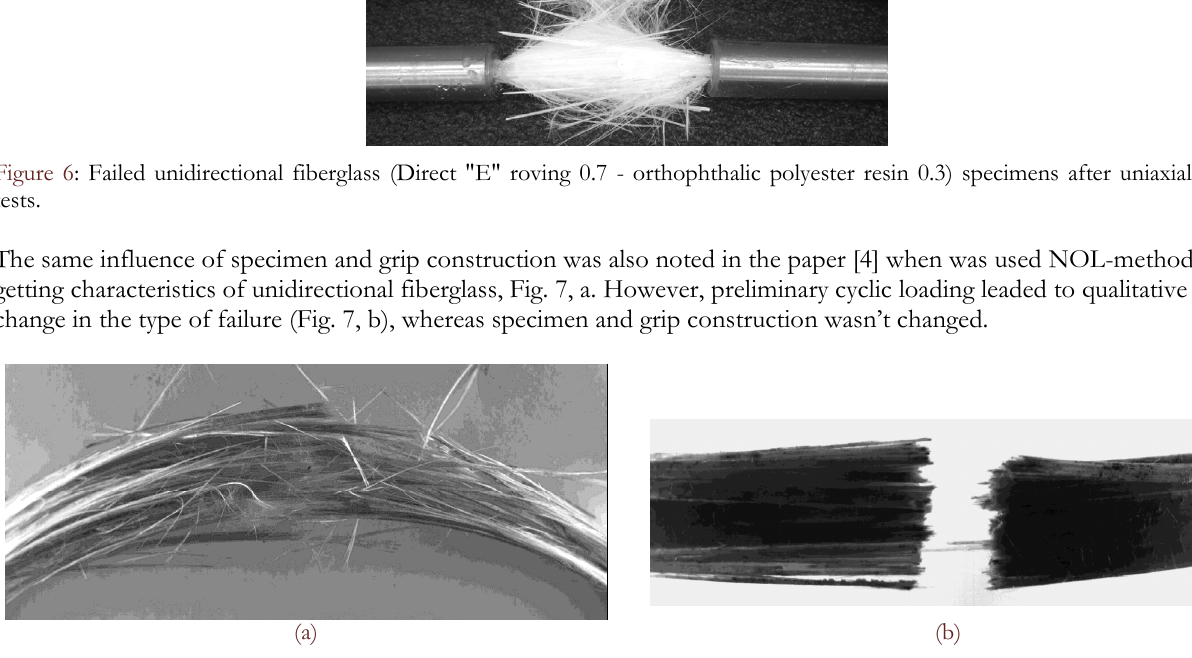
Figure 7: RBN 1680-UP 2217 fiberglass failure at static deformation by rigid half-discs (a) and after cyclic loading